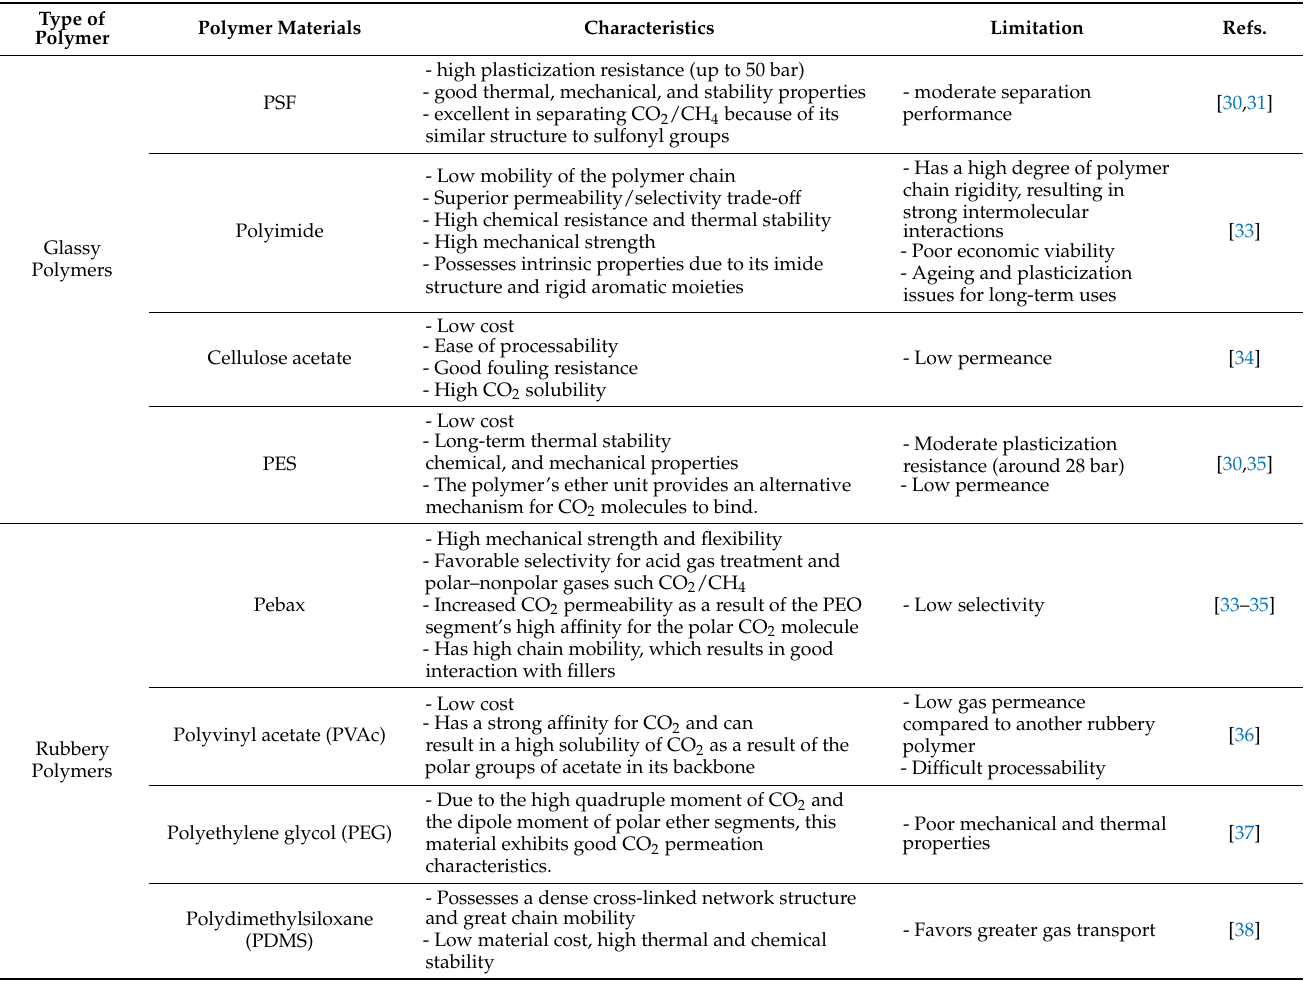
Table 2. Characteristics of Glassy and Rubbery Polymer